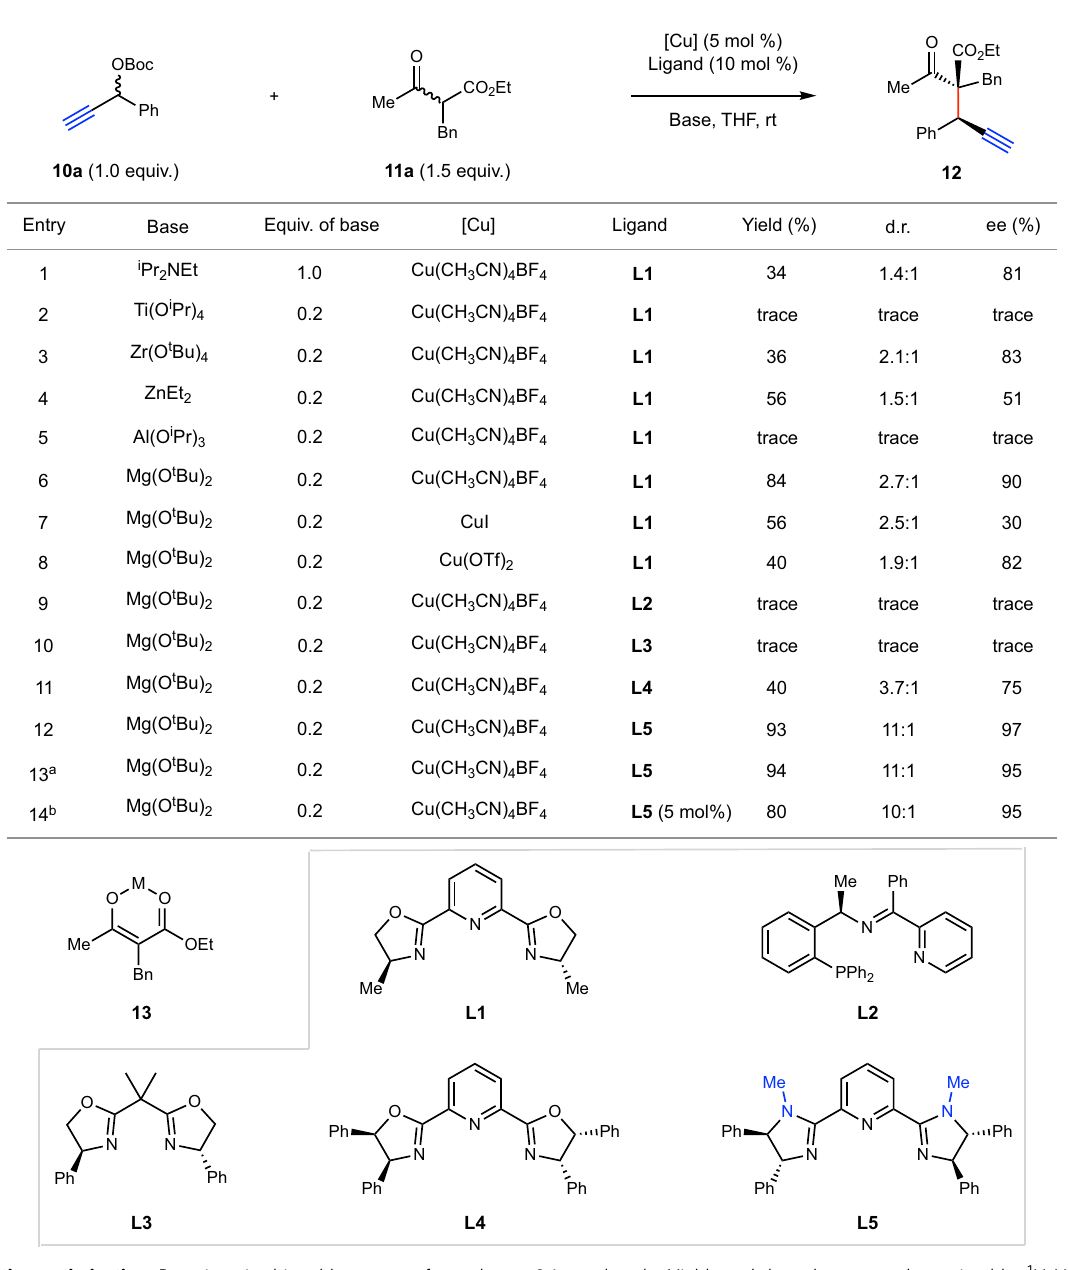
Fig. 2 Condition optimization. Reactions in this table were performed on a 0.1 mmol scale. Yields and d.r. values were determined by 1 H NMR spectroscopy of the crude reaction mixture with 1,1,2,2-tetrachloroethane as an internal standard. The ee values were determined by HPLC analysis. a 10a (1.5 equiv.) and 11a (1.0 equiv.) were used. b The ratio of ligand to Cu is